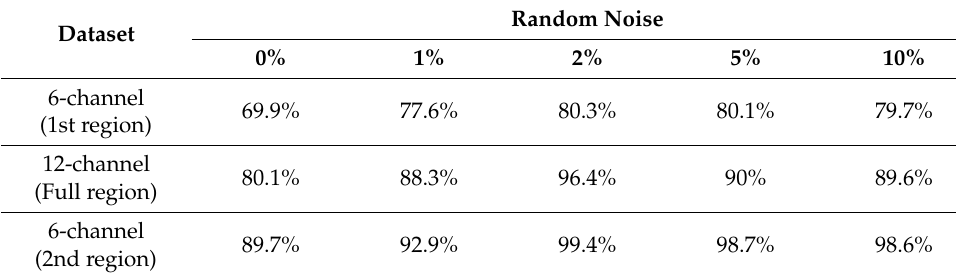
Table 5. Accuracy of optimized model evaluated by testing dataset after Bayesian optimization.